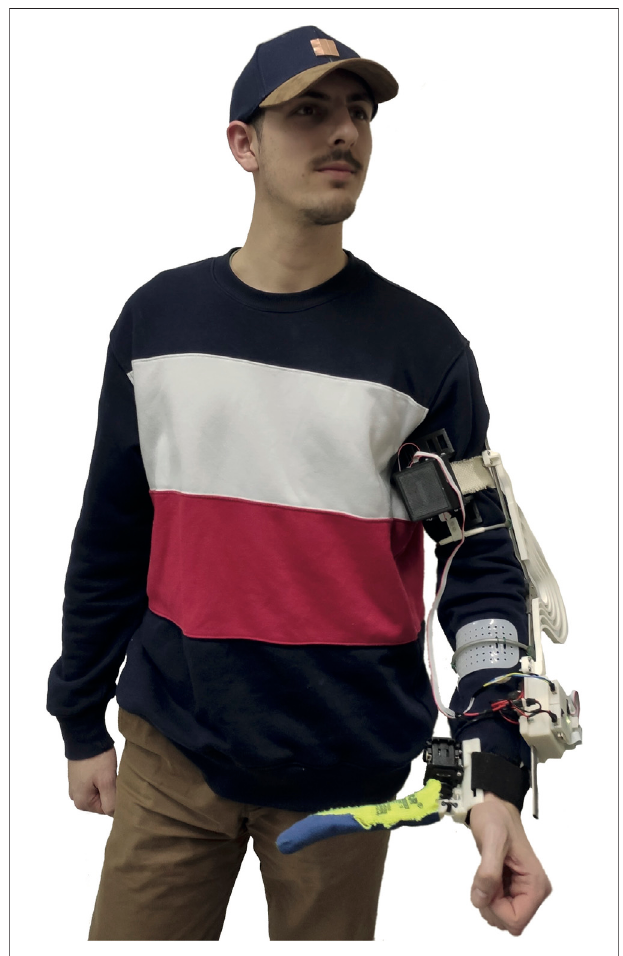
FIGURE 1 | The SoftPro wearable system worn by a healthy